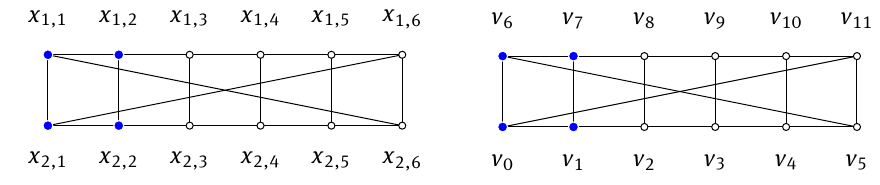
Figure 7: The Möbius ladder K 2